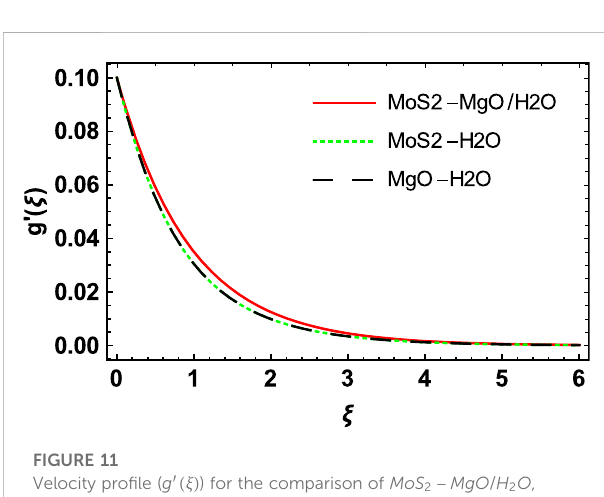
FIGURE 10 Velocity pro fi le ( f ′ ( ξ ) ) for the comparison of MoS 2 − MgO / H 2 O , MoS 2 − H 2 O , and MgO − H 2 O .